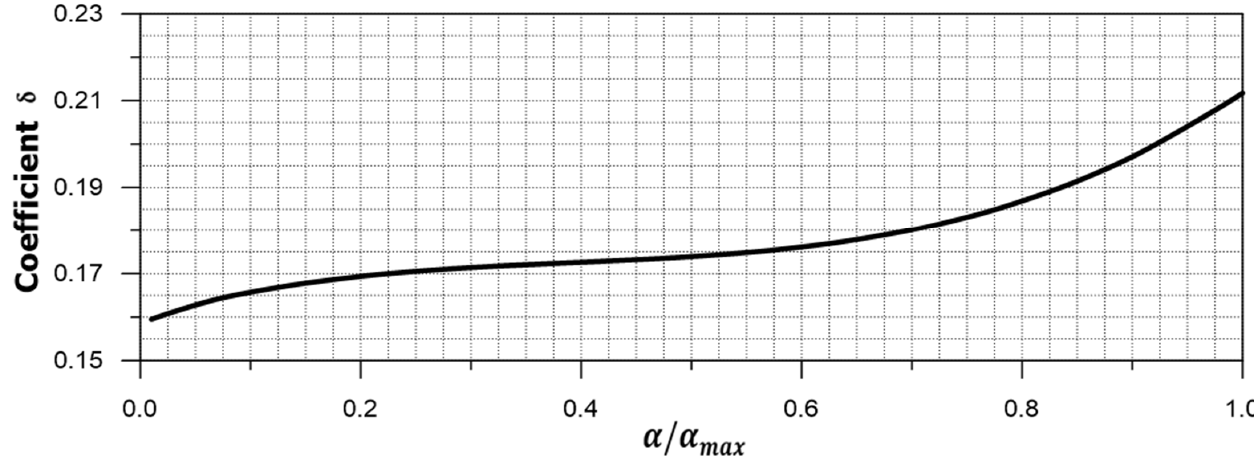
Figure 5. Coefficient δ versus α / α max .